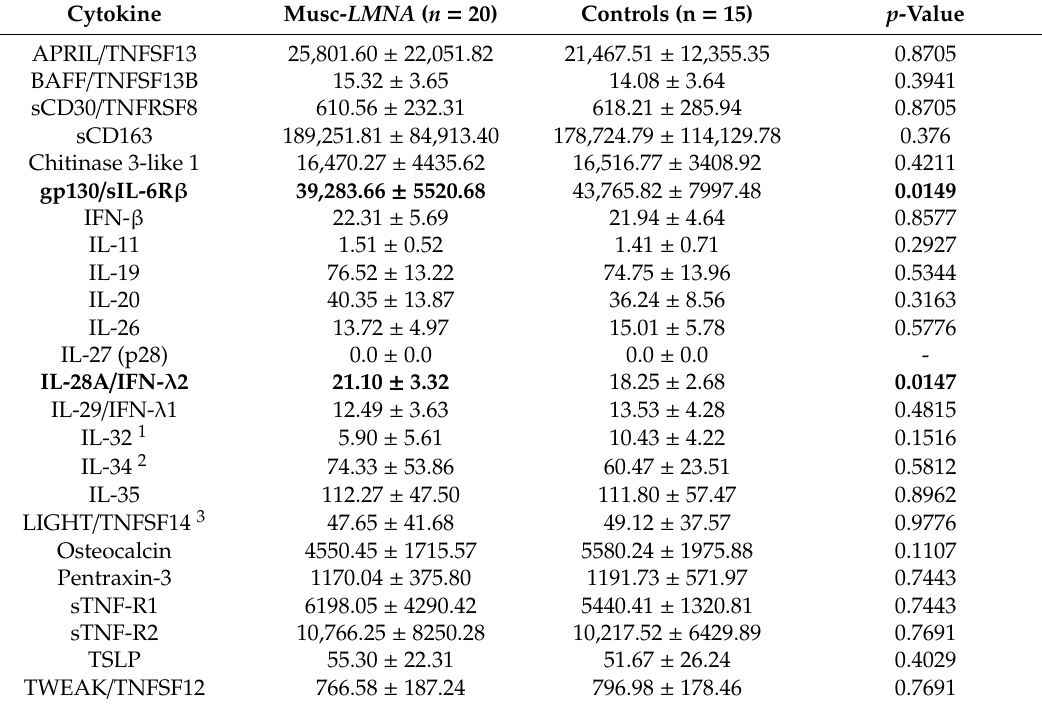
Table 4. Serum concentration of TNF- α -related cytokines in Musc-LMNA and controls.